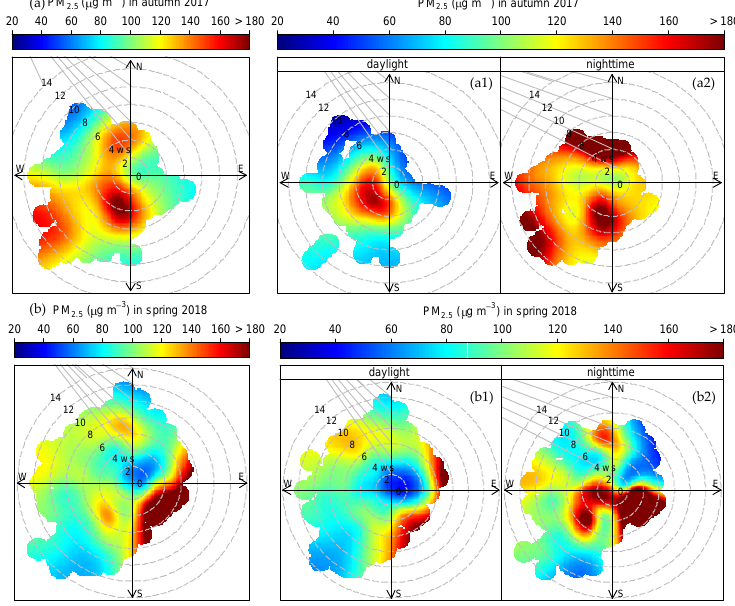
Figure 3. Relationship of PM 2.5 concentrations with wind direction and wind speed during the periods from 19 October to 23 November 2017 and 1 April to 13 May 2018. ( a ) Relationship of PM 2.5 concentrations with wind direction and wind speed during the periods from 19 October to 23 November 2017. ( a1 ) The daylight relationship of PM 2.5 concentrations with wind direction and wind speed during the periods from 19 October to 23 November 2017. ( a2 ) The nighttime relationship of PM 2.5 concentrations with wind direction and wind speed during the periods from 19 October to 23 November 2017. ( b ) Relationship of PM 2.5 concentrations with wind direction and wind speed during the periods from 1 April to 13 May 2018. ( b1 ) The daylight relationship of PM 2.5 concentrations with wind direction and wind speed during the periods from 1 April to 13 May 2018. ( b2 ) The nighttime relationship of PM 2.5 concentrations with wind direction and wind speed during the periods from 1 April to 13 May